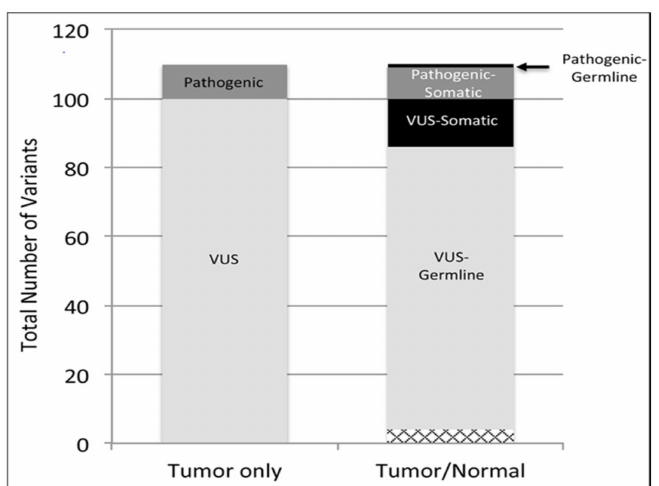
Figure 2. Percentage of cases with actionable variants.